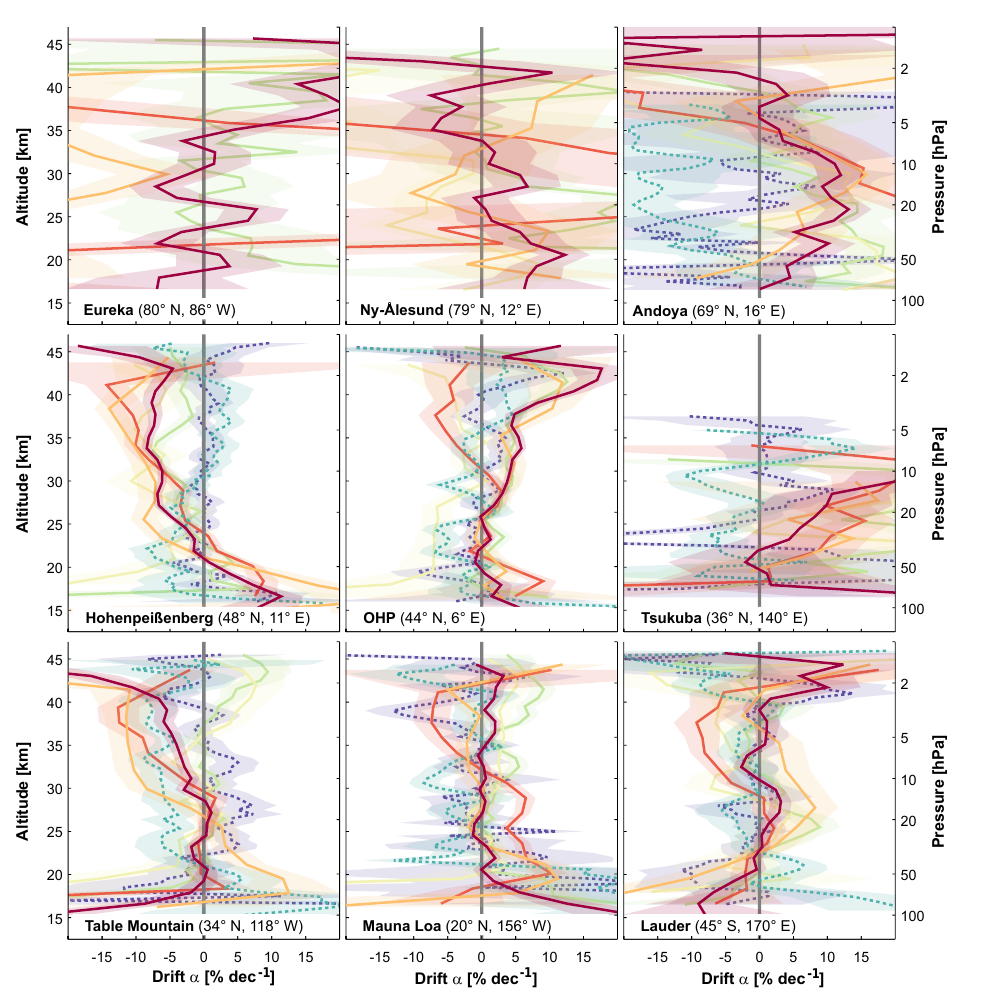
Figure 4. Comparison of the vertical structure of the drift α of two historic (dashed lines) and five recent (solid) satellite records relative to stratospheric lidar observations at nine NDACC stations. The shaded area represents the unadjusted 68% confidence interval, which does not include possible uncertainties from differences in sampling or from inhomogeneities in the lidar network. The analysis is performed in the native profile representation of each satellite